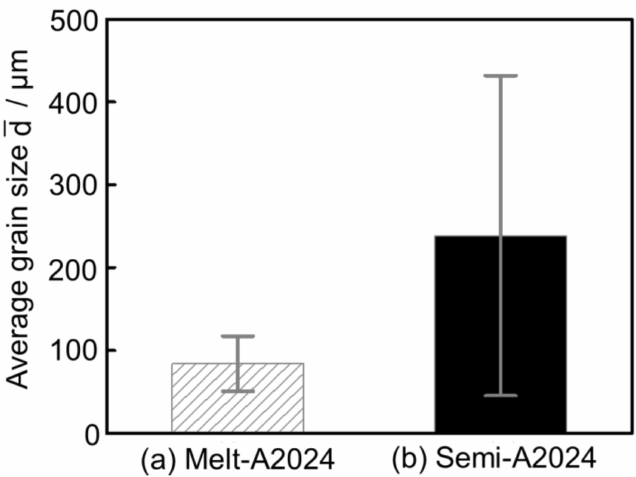
Figure 9. Average grain size d ; ( a ) Melt-A2024; ( b ) Semi-A2024. The error bars show the standard deviations.